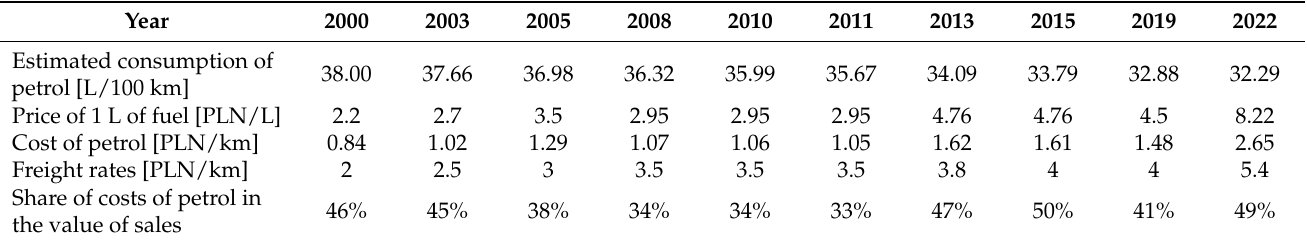
Table 9. Changes of costs and freight rates in road transport in Poland with the use of HDV in years